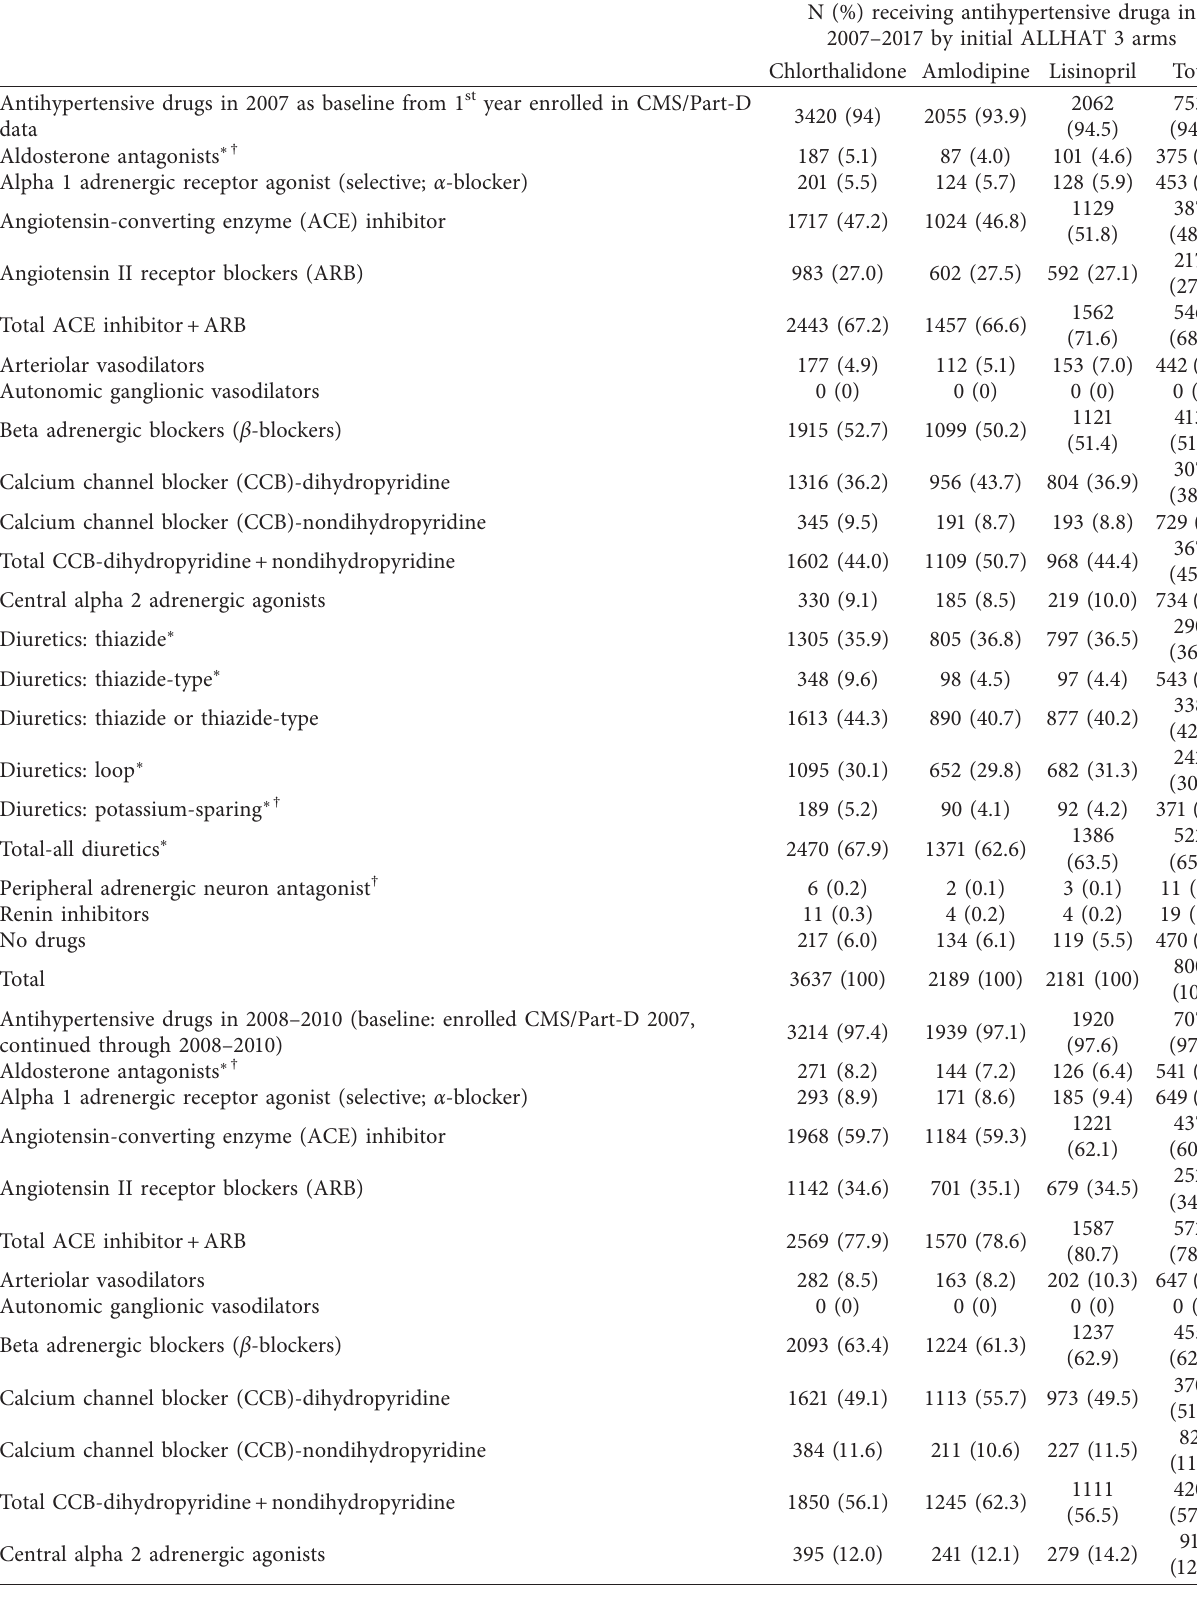
Table 1: Patterns of posttrial antihypertensive drug utilization from Medicare Part-D drug coverage as of